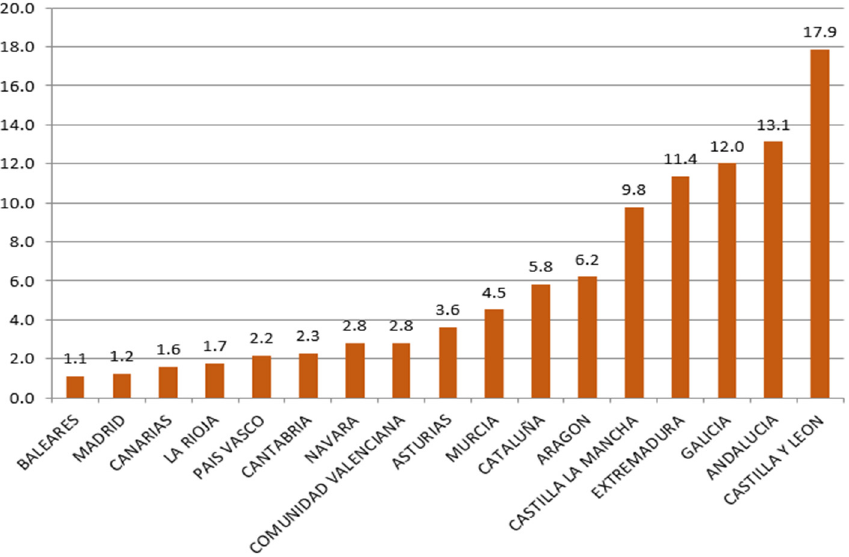
Figure 3. Distribution of EAFRD funds by Region. Period 2014–2019 (%). Source: European Commission and own calculations.